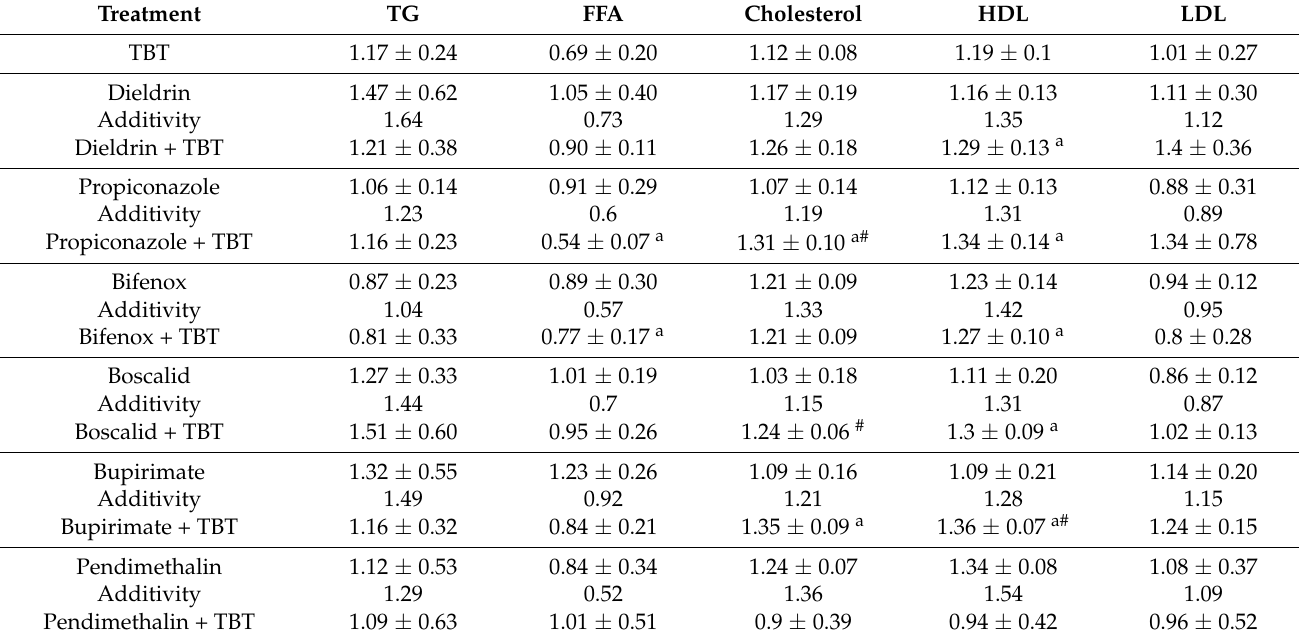
Table 5. Effects of pesticide treatments on plasmatic biochemical parameters. Results are expressed as fold change of DMSO group (mean ± standard error). “a” represents significant difference with DMSO. p < 0.05 is considered significant according to one-way ANOVA test followed by Tukey’s multiple comparisons test. # indicates a significant difference ( p < 0.05) between the observed effect of TBT + Pesticide and the calculated additivity of TBT + Pesticide using a one-sample t